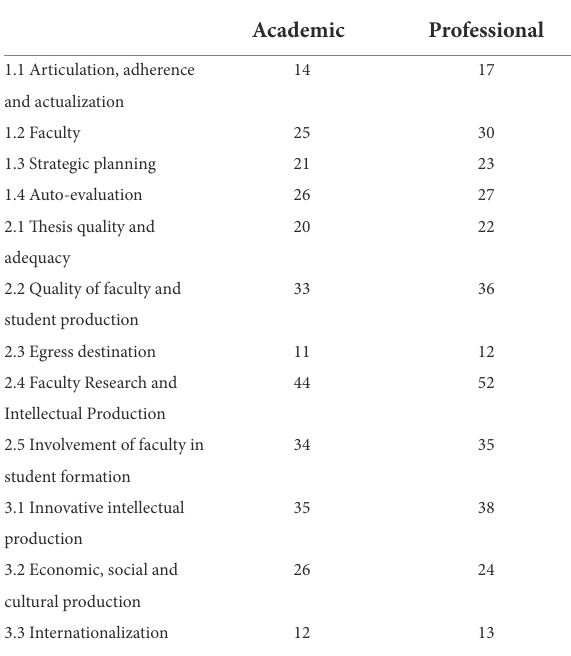
TABLE 3 Weights of the questions and items of the current (2021) evaluation form. Axis Items Items